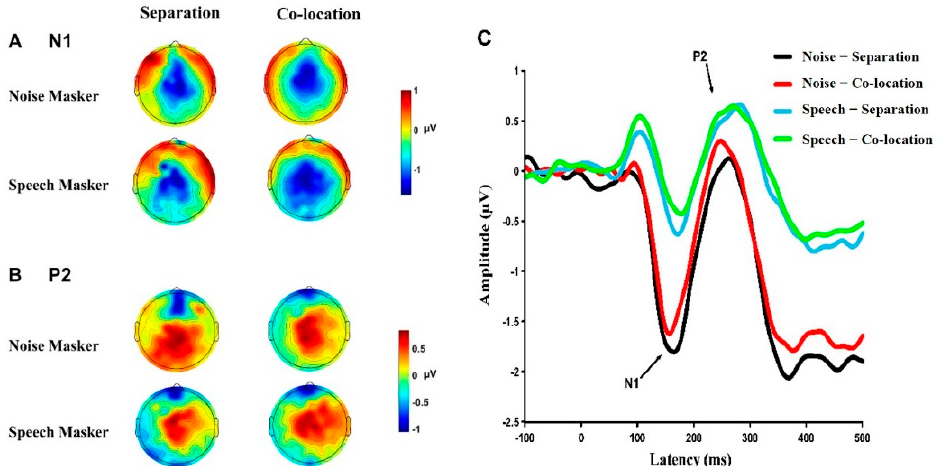
Figure 4. ERPs evoked by the prepulse. ( A – C ) Comparisons of the group-mean N1, P2, and N1P2 peak-to-peak amplitudes recorded at the sites near the frontoparietal cortex under the four conditions. ( D , E ) The mean latencies of the N1 and P2 components under the four conditions. Data are expressed using mean ± SEM; *, p < 0.05; **, p < 0.01; ***, p < 0.001.